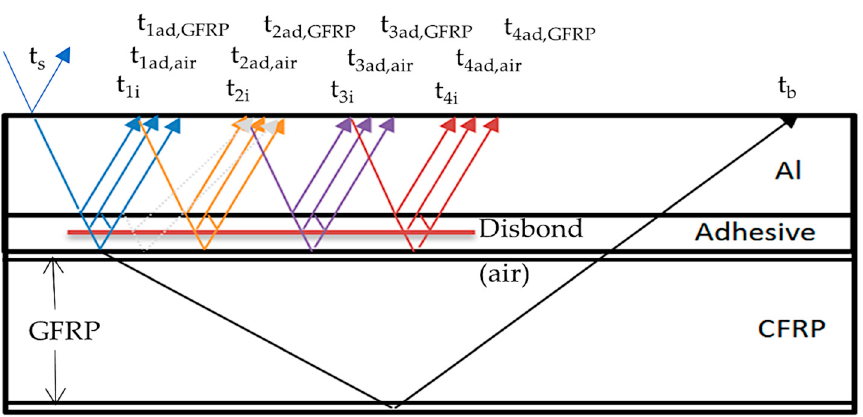
Figure 6. Path of ultrasonic wave propagation and reflection from the boundaries.